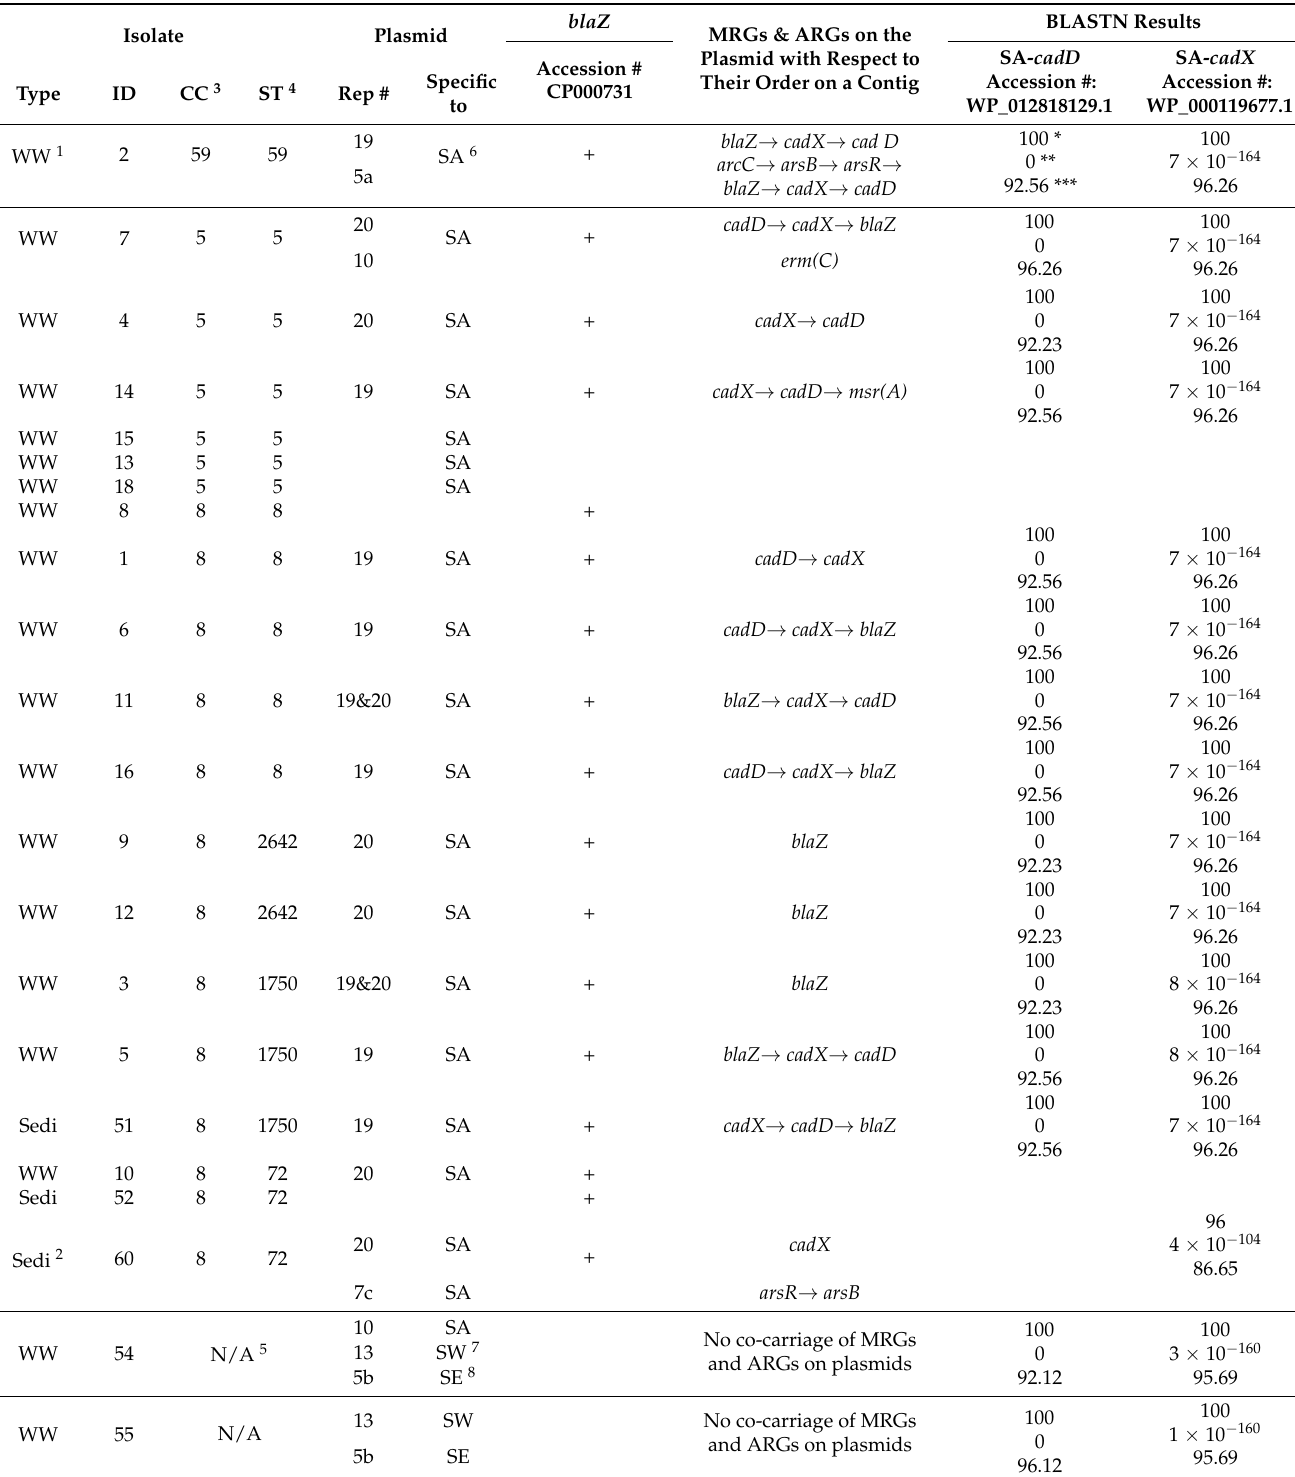
Table 4. The presence of metal and antibiotic resistance genes on plasmids in sewage-associated staphylococci species (values in two last columns: percent query coverage (top), E-value (middle), and percent identity (bottom). Isolate Plasmid